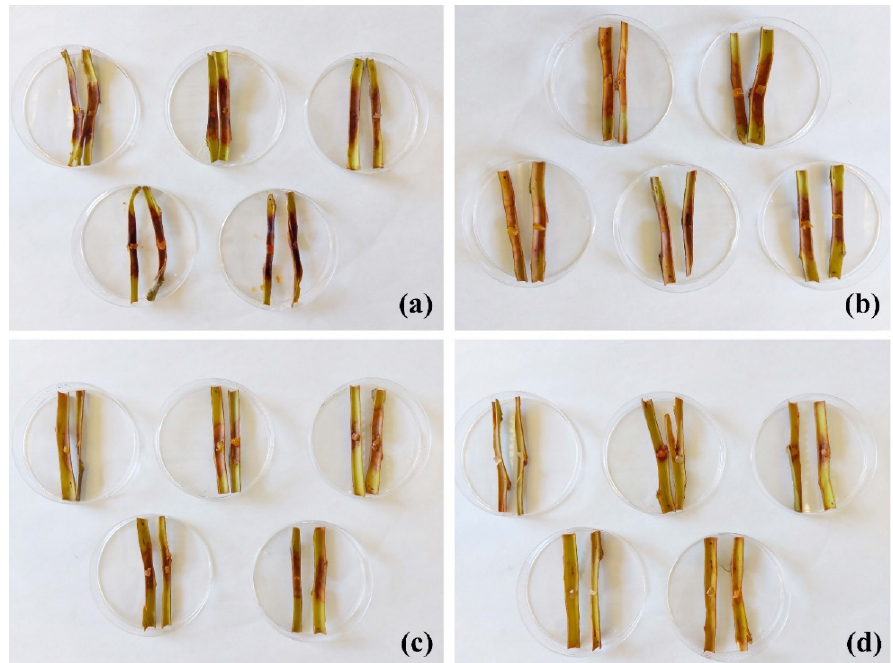
Figure 3. Canker lengths observed in ‘Garnem’ excised stems artificially inoculated with P. cactorum and treated with the COS– Q. suber bark extract conjugate complex at different concentrations: ( a ) control, no treatment; ( b ) MIC = 375 μ g·mL − 1 ; ( c ) MIC × 5 = 1875 μ g·mL − 1 ; ( d ) MIC × 10 = 3750 μ g·mL − 1 . Only half of the replicates per treatment are shown. Table 5. Results of the Kruskal–Wallis test, followed by multiple pairwise comparisons using the Conover–Iman procedure for mean lengths of cankers in excised stems after inoculation with P. cactorum . The mean rank values accompanied by the same letters are not significantly different ( p - value (one-tailed) < 0.0001, α = 0.05).